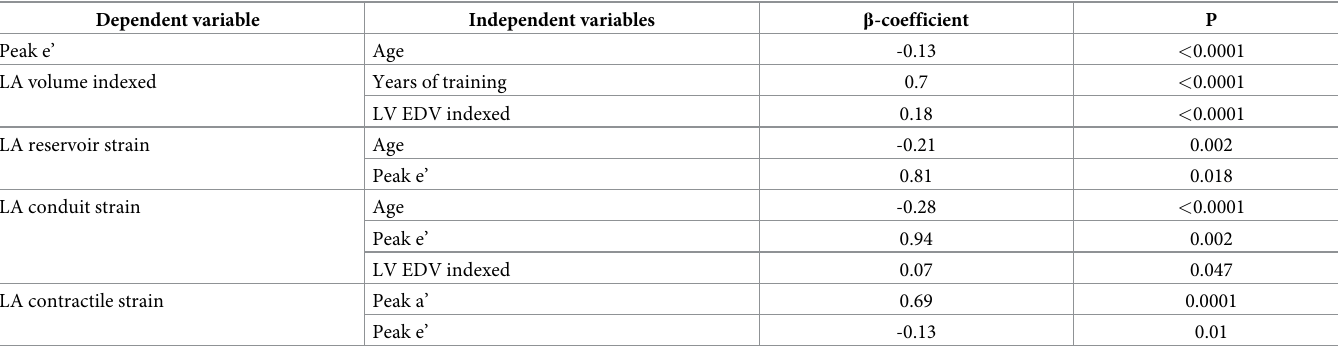
Table 4. Multiple regression stepwise model